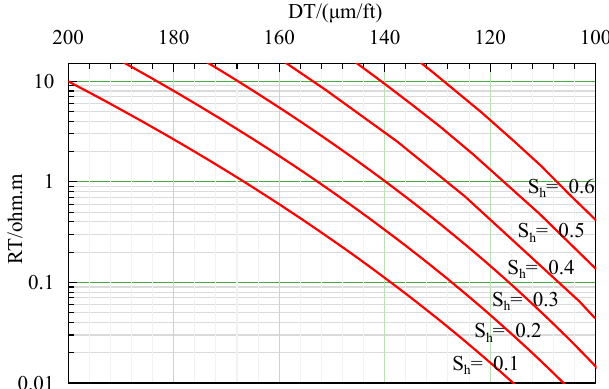
Figure 13. Resistivity–acoustic time difference cross chart.